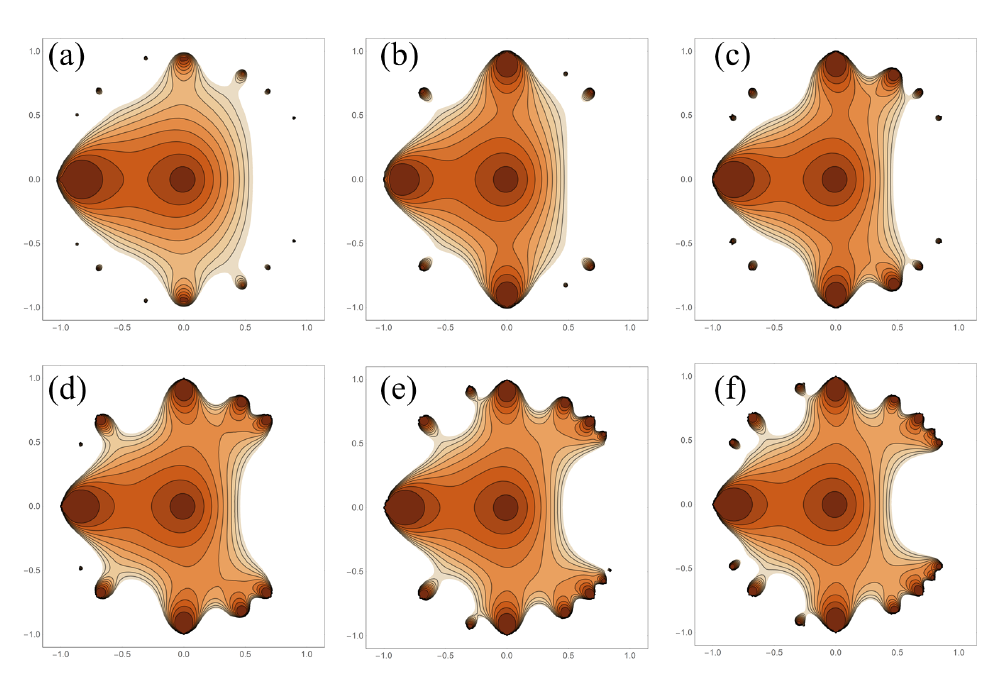
( 1 ) ( z ) for M = 1 through M = 6 (( a ) through ( f ) 10